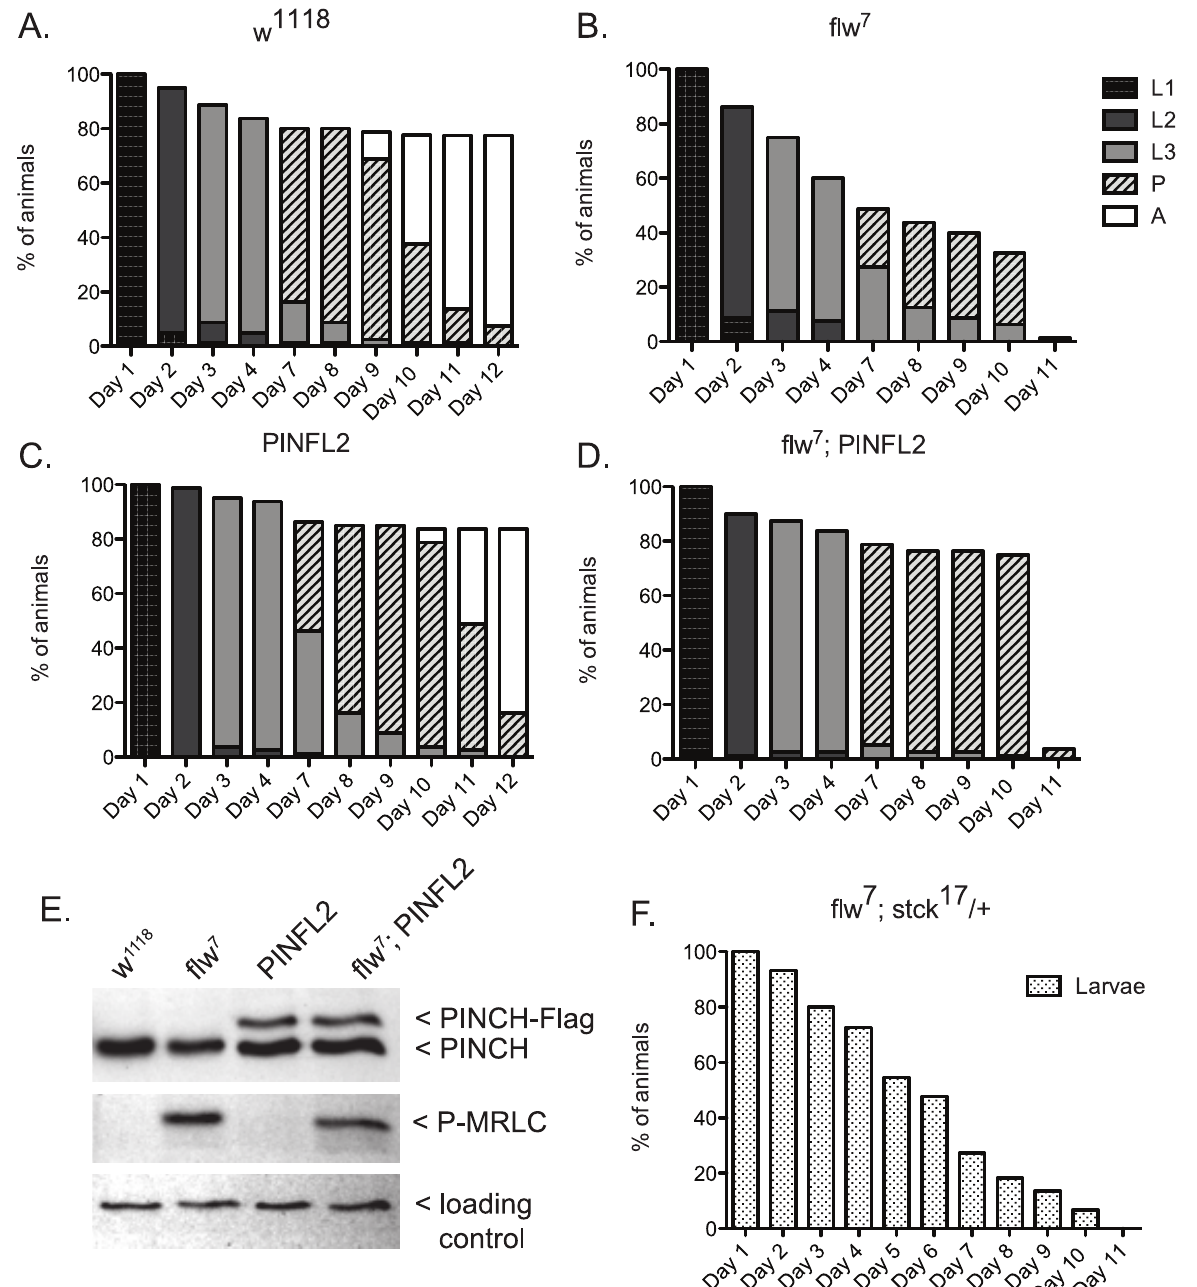
Figure 2. Expression of PINCH-Flag fully rescues the larval lethality of the flw 7 mutant independently of MRLC/Sqh dephosphorylation. A–D) For each genotype, graphs show the percentage of animals of the given developmental stage at the indicated time points. Pupae present at the final time point shown in A and C eventually eclosed as adults, whereas pupae in B and D subsequently arrested. E) Representative western blot of four-day-old L3s confirms that PINCH expression is elevated in the PINFL2 and flw 7 ; PINFL2 larval lysates (transgenic PINCH is 44% of endogenous levels for both samples, by densitometric analysis) and that PINFL2 expression does not affect the phosphorylation state of MRLC/Sqh. The ribosomal protein RACK1 is used as a loading control. F) Survival of flw 7 ; stck 17 / + larvae (n=44) is plotted against